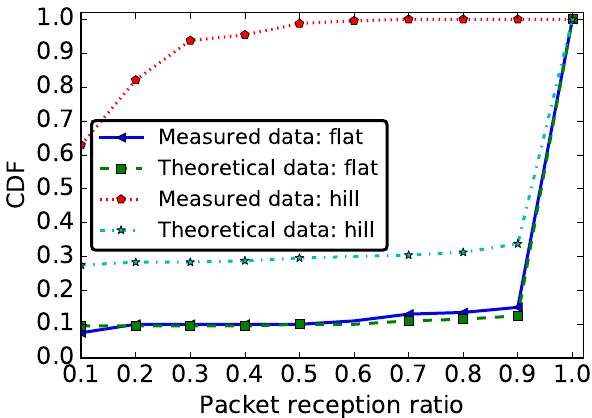
Figure 15. PRR Validation: empirical and theoretical CDF.